Question: Name the type of graph shown.
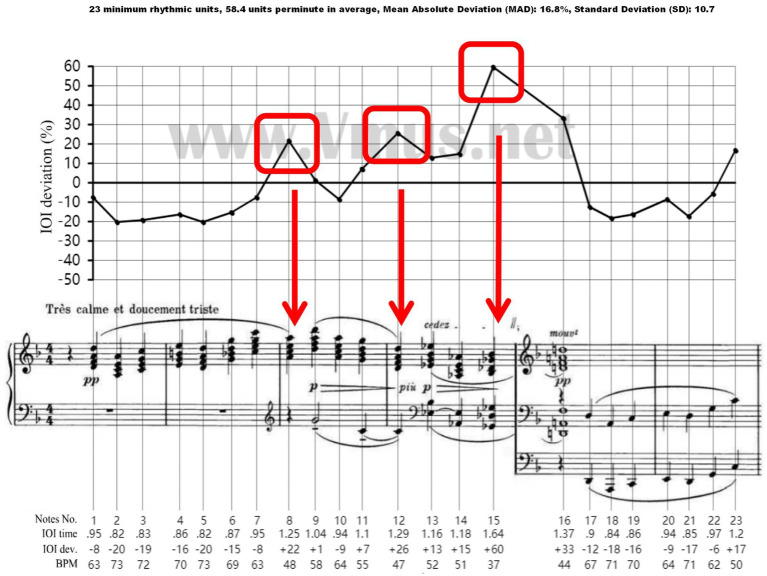
Answer: line